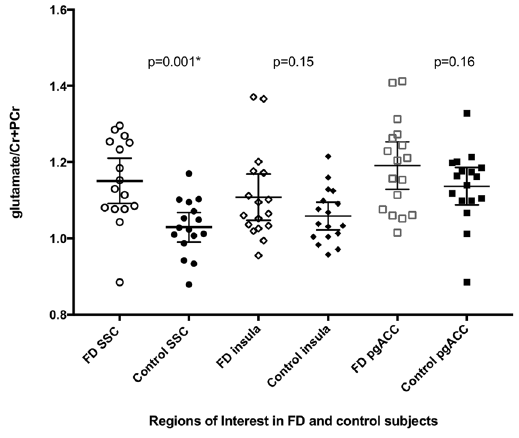
Figure 2. Glu/Cr + PCr of FD-PDS and controls in Left SSC, insula and bilateral pgACC. Glu/ Cr + PCr = relative regional Glutamate concentration with total regional creatine + phosphocreatine as reference. SSC = somatosensory cortex, pgACC = perigenual anterior cingulate cortex. * p < 0.003 Bonferroni correction: p < 0.05/(3 regions × 5 metabolites).